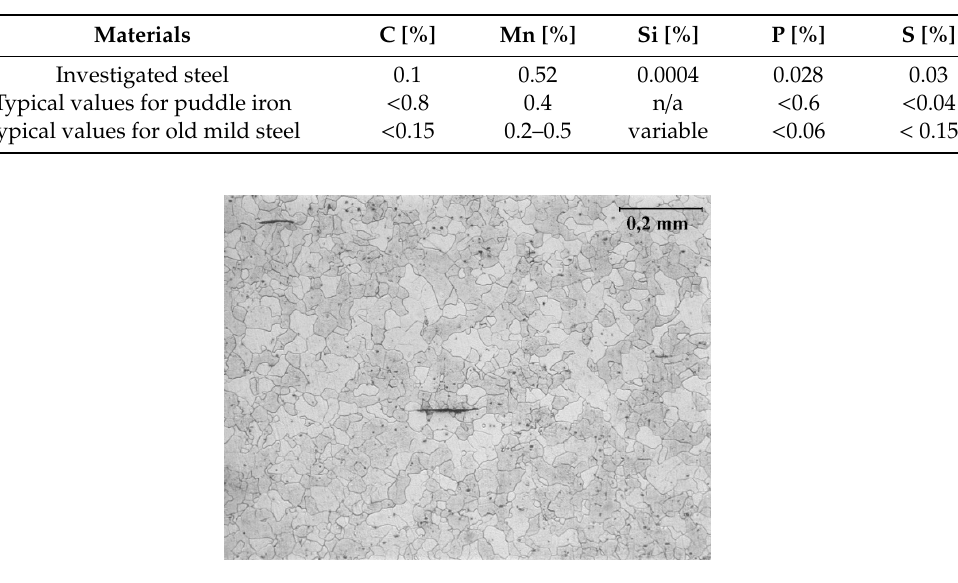
Figure 1. The microstructure of the tested long ‐ term operated mild steel .